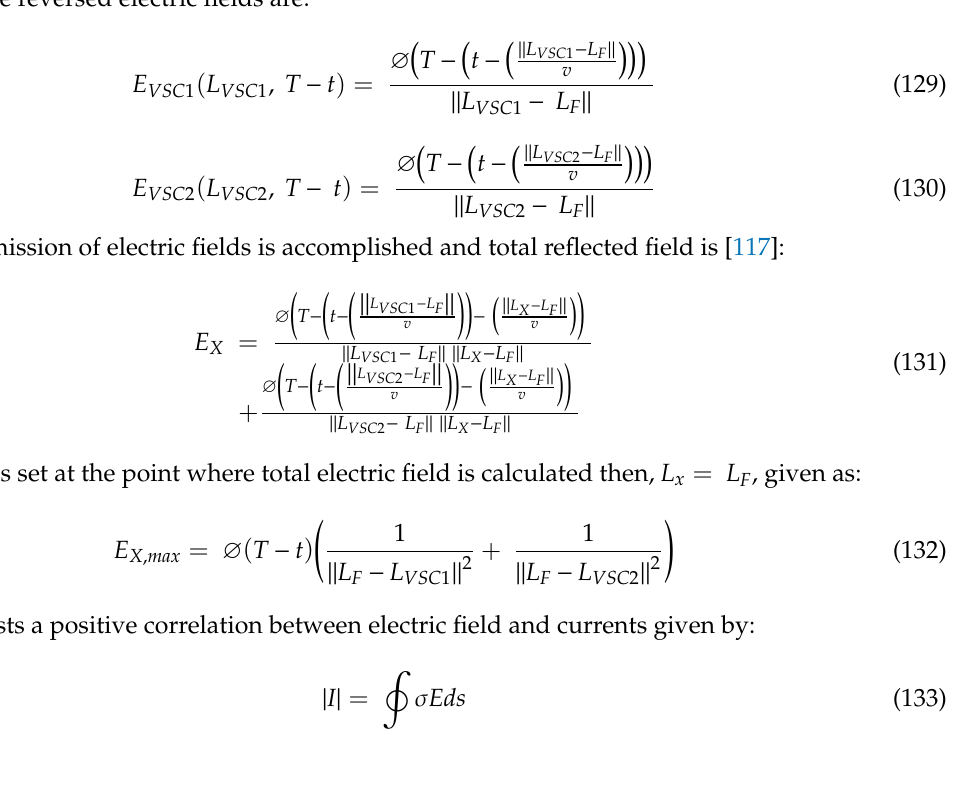
Figure 28. Electromagnetic time reversal (EMTR) based model of high-voltage direct current (HVdc) transmission system.